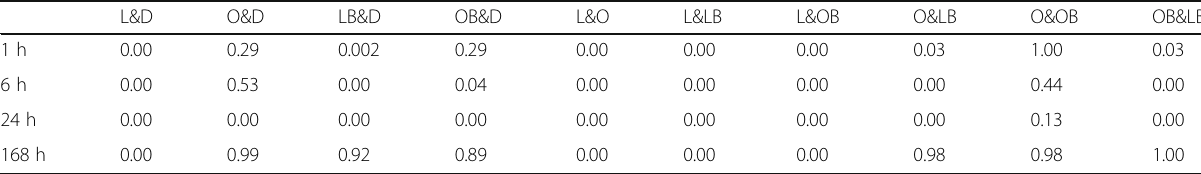
Table 4 Release of nickel ions from NiTi wires at various